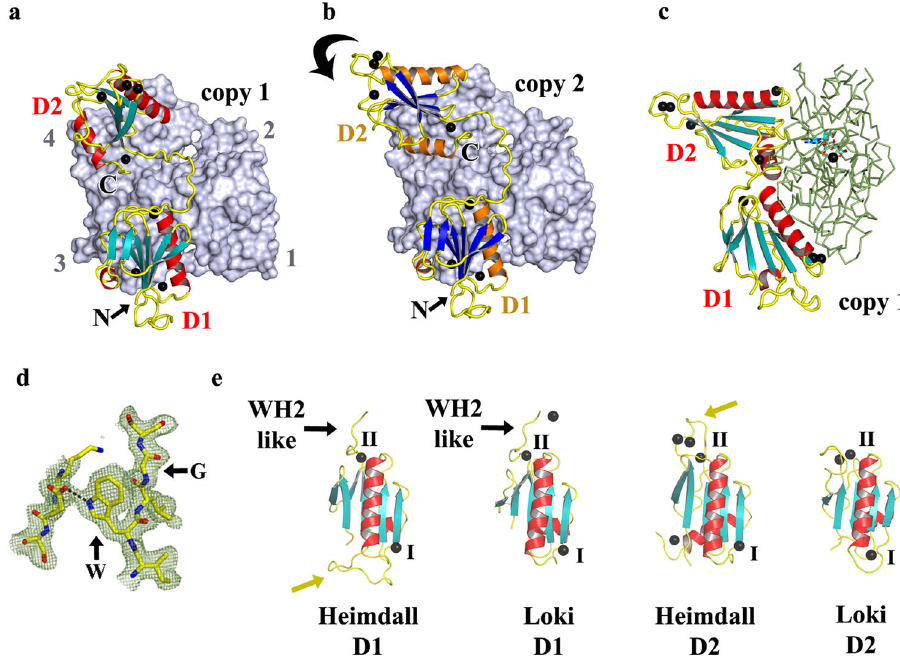
Fig. 3 The structure of the Heim2DGel:rActin complex. a Structure of one copy of the Heim2DGel/rActin complex from the crystallographic asymmetric unit. rActin is shown as a surface (slate) and Heim2DGel is shown in schematic representation. Calcium ions are depicted as black spheres and the N- and C-termini are labeled N and C, respectively. Actin subdomains are numbered. b Structure of the second copy of the Heim2DGel/rActin complex in which glycerol (not shown) has inserted into the D2/actin interface. The arrow indicates the movement of D2 relative to ( a ). c Side view of ( a ) with actin shown as a ribbon (green) for comparison with Fig. 2. d OMIT map electron density (contour level 1 σ ) around the characteristic gelsolin WG motif in D1 copy 1. e Comparison of the individual gelsolin-like domains and their calcium-binding sites. I and II indicate the conserved calcium binding sites Type I and Type II, respectively. D1 and D2 refer to domains 1 and 2 19 . The C-terminal extension of D1 contains a WH2-like motif in each case 24 . Arrows (mustard) indicate insertions in the Heim2DGel